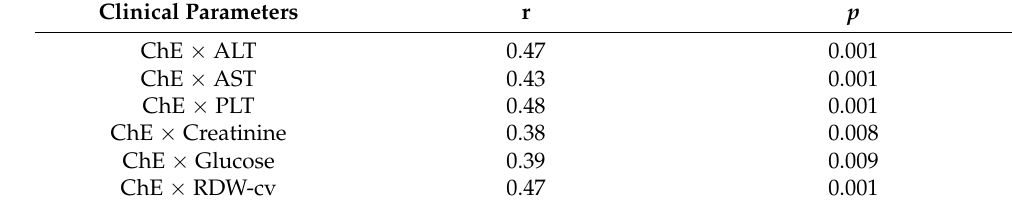
Table 4. Statistical correlation between biological parameters and ChE.